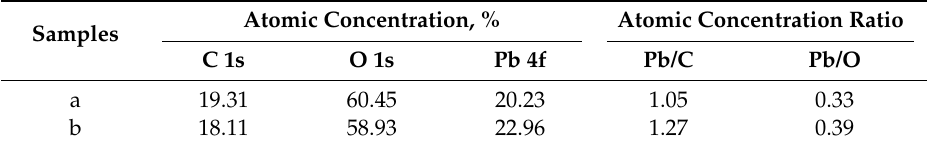
Table 2. Atomic concentration of cerussite samples treated with chloride ions: ( a ) before; ( b ) after. Table 3. Binding energy of each element from various cerussite samples treated with chloride ions: Samples ( a ) before; ( b ) after.